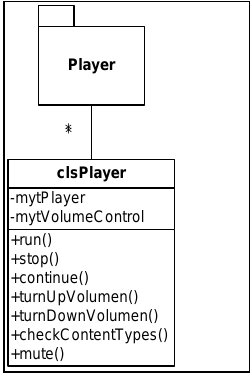
Figure 7. Class diagram of contents reproduction